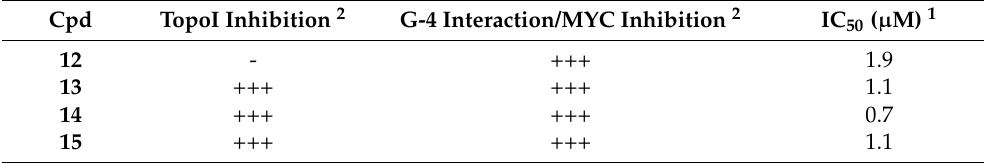
Table 3. Summary of the biological activities of dibenzoquinoxalines 12 – 15 .